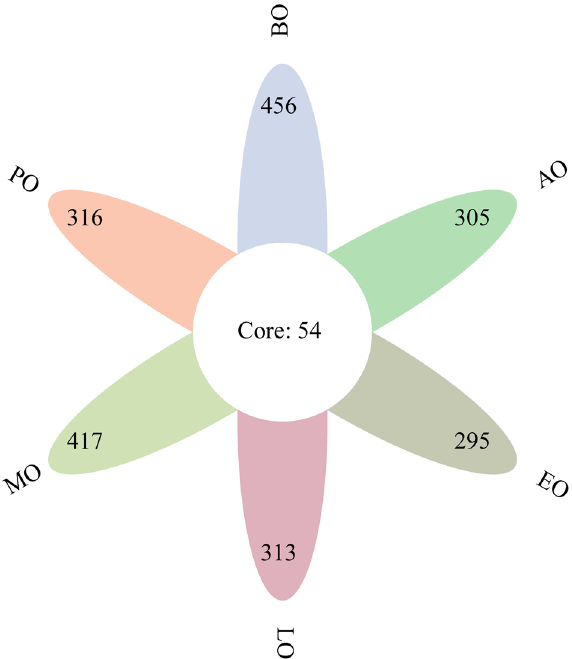
Figure 1. The features composition of the intestinal bacteria of honeybees in winter. The number in the figure is the number of features and different colors represent different